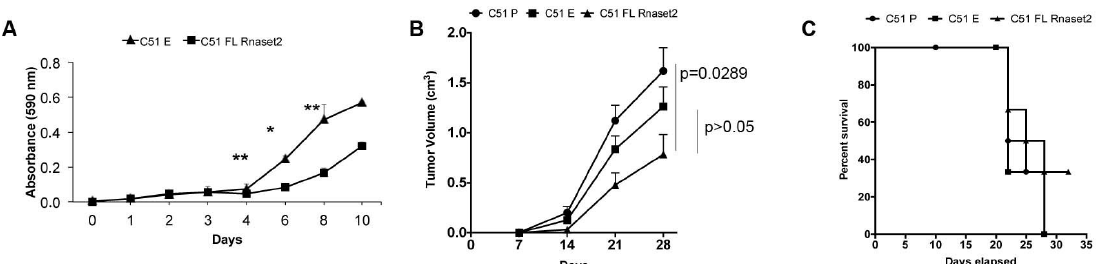
Figure 3. Assessment of in vitro cell proliferation rate (MTT assay) in full length Rnaset2 -overexpressing C51 clones (FL Rnaset2 ) in comparison to empty vector-transfected C51 clones (C51 E) (panel A ); in vivo analysis of tumor growth in BALB / c mice groups ( N = six animals in group) injected with C51 P, C51 E, and C51 FL Rnaset2 cell lines (panel B ); survival curves versus time (days) of BALB / c mice groups injected with C51 P, C51 E and C51 FL Rnaset2 cell lines (panel C ). For MTT assay and tumor growth, an ANOVA statistical analysis was performed assuming p < 0.05 as a threshold value. * p < 0.05; ** p < 0. 01.